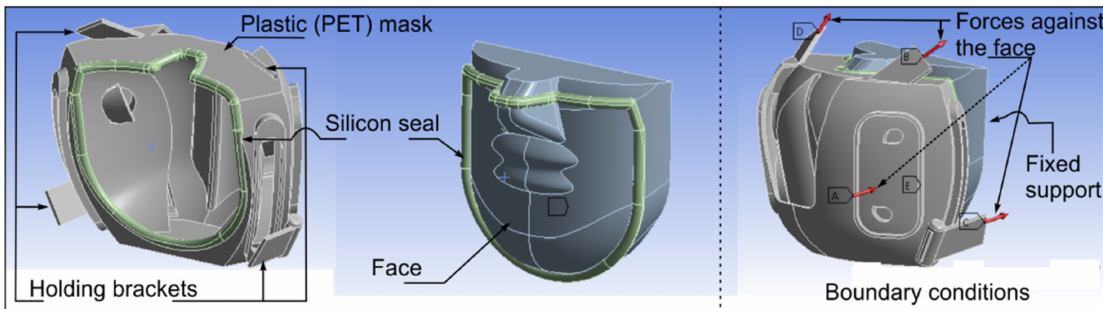
Figure 7. Conceptualization of the mask, seal, and face for the static structural